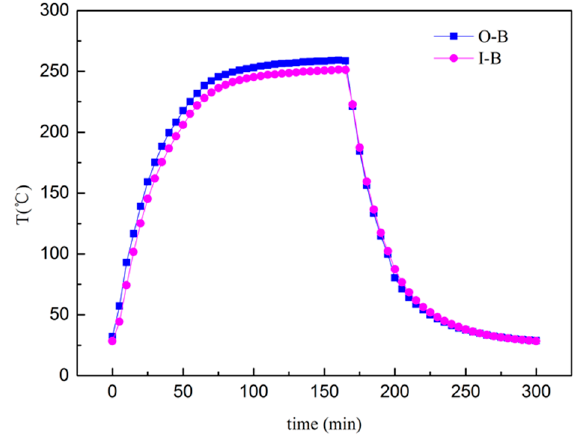
Figure 5. Temperature changes of the adsorbent bed.